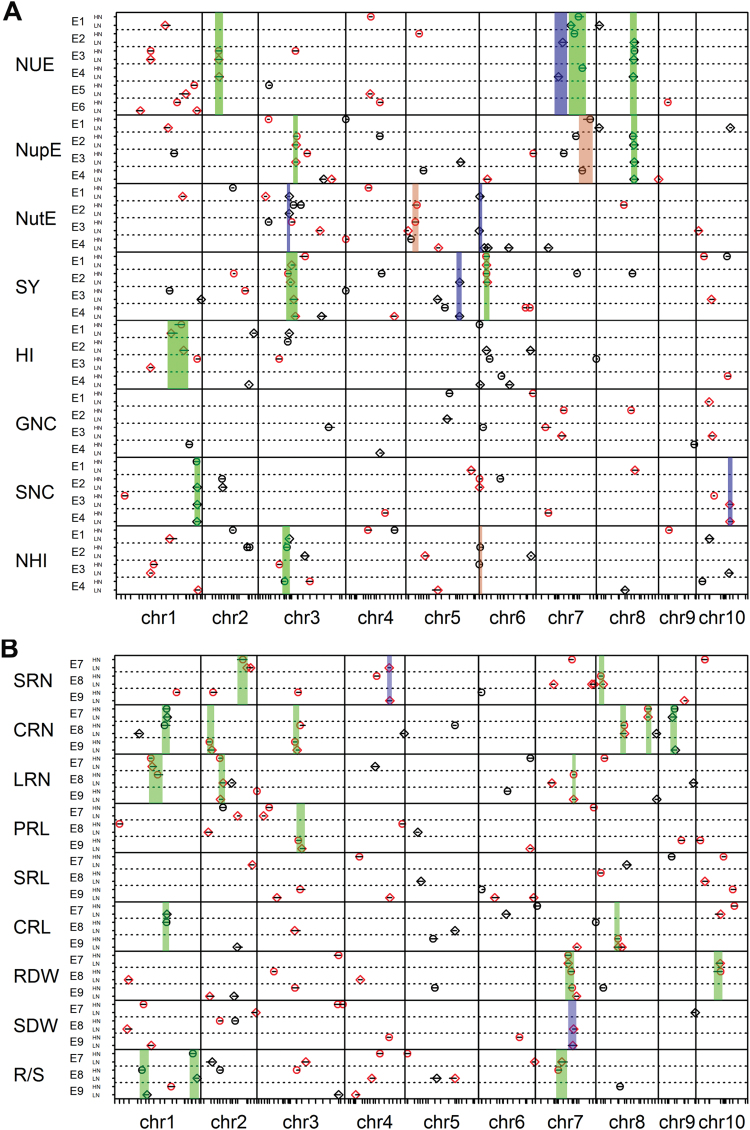
Genomic regions of 331 QTLs detected for (A) NUE-related traits across different field environments (E1–E6 for NUE, and E1–E4 for others) and (B) RSA-related traits across three independent hydroponics experiments (E7–E9) under HN (open circles) and LN (open diamonds) levels. For each QTL symbol, the horizontal line indicates conﬁdence intervals and the centre of the plot indicates the most likely position. Red symbolises a positive additive effect from Ye478 alleles and black a positive additive effect from Wu312 alleles. The rectangles represents the sQTL regions across the genome: green is representative for the constitutive sQTL, brown for HN-specific sQTL, and blue for the LN-specific sQTL.